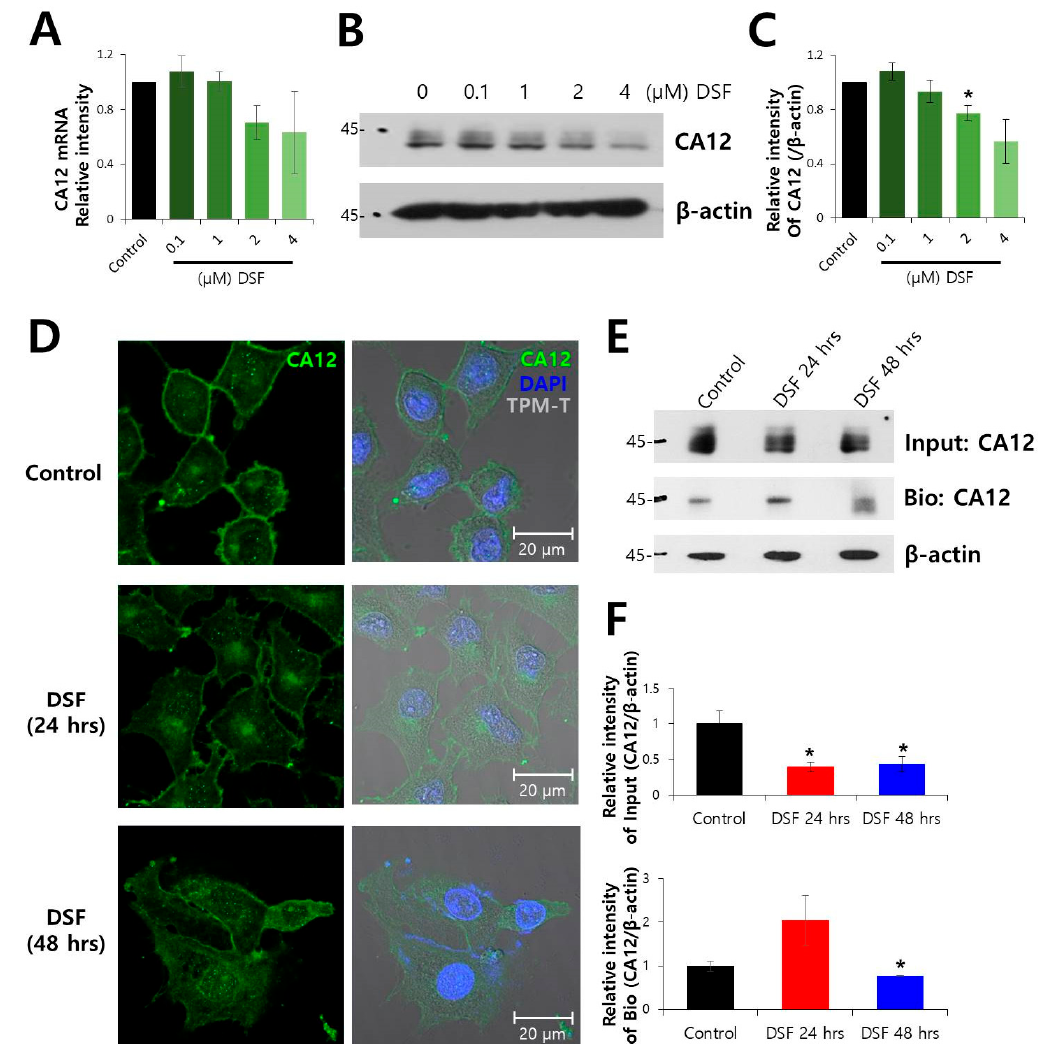
Figure 1. Surface protein expression of CA12 protein was decreased by DSF treatment. ( A ) Analysis of CA12 mRNA expression at rising concentrations from 0.1–4 µ M DSF for 48 h (n = 5). ( B ) Protein expression of CA12 at indicated DSF concentration. ( C ) Analysis of relative CA12 intensity (n = 3, * p < 0.05). ( D ) Immunostained images of CA12 (green), nucleus (DAPI, blue), and cell morphology (TPM-T, gray) following 2 µ M DSF treatment. The scale bars represent 20 µ m. ( E ) Time-dependent changes in surface expression of CA12 in the presence of 2 µ M DSF in A549 cells. The β -actin and input CA12 blots were used as loading controls. ( F ) Analysis of relative intensity of CA12 for input and biotinylated (Bio) blot. Bars represent mean ± SEM (n = 4, *p < 0.05).